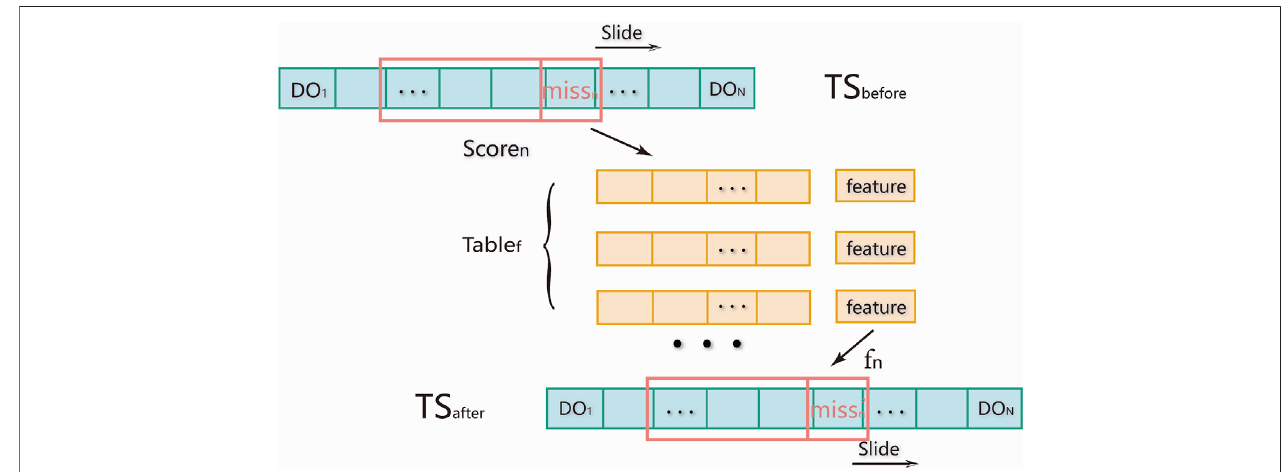
FIGURE 2 | SSMF method for fi lling missing